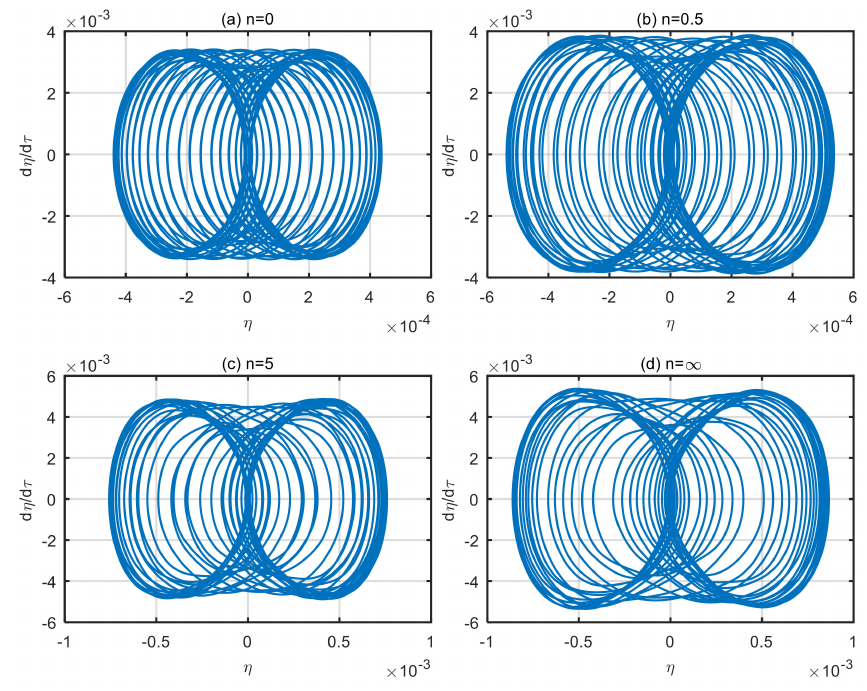
Figure 2. Phase diagram of microtubes with different power-law index of the volume fraction. ( a ) n = 0; ( b ) n = 0.5; ( c ) n = 5; ( d ) n = ∞